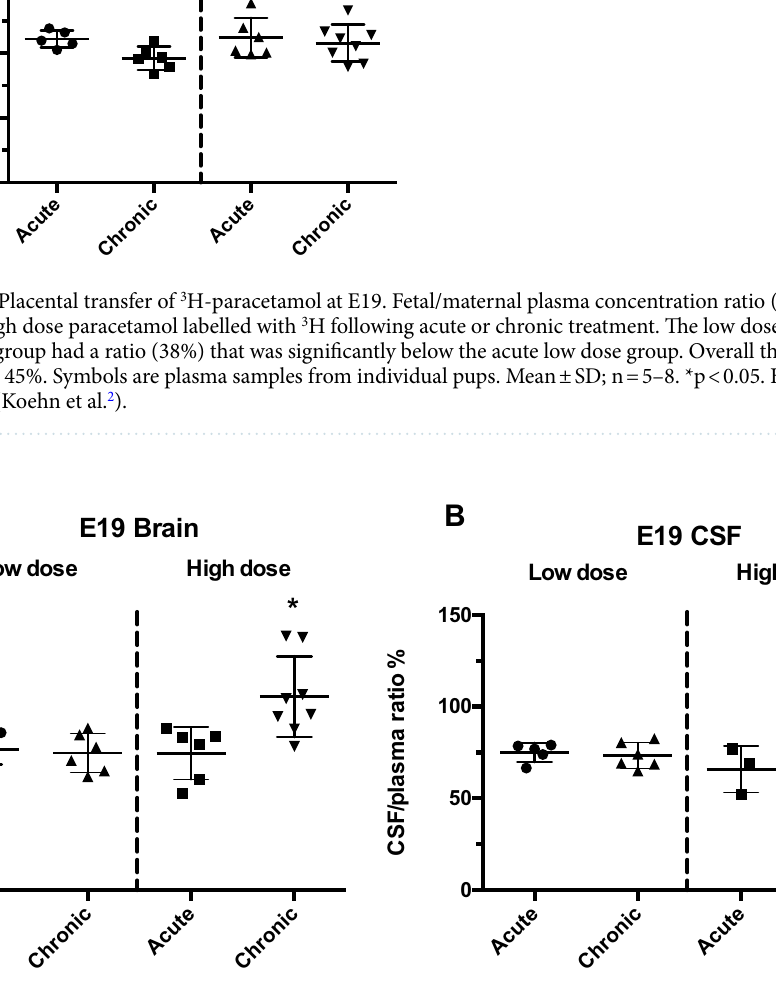
and adult (Fig. 6D) rats exposed in vivo to 3 H-paracetamol (15 mg/kg) acutely. Figure 6A,B shows the minimal background level in control brains that were either: (i) not exposed to any radiolabelled drug (Fig. 6A) and (ii) a brain that was exposed to radiolabelled digoxin (Fig. 6B), which only enters the adult brain to a limited extent 2 . When compared to radioactive standards on the same film, the level of 3 H-radioactivity in both Fig. 6A and Fig. 6B were below the lowest detection of 3.1 nCi/mg. Sections from brains exposed to paracetamol show its uniform distribution in the P4 brain, with granular deposits throughout (Fig. 6C). Quantification from 3 H standards on the film indicates that radioactivity in the P4 brain was approximately 18.4 nCi/mg. Figure 6D shows paracetamol in a similar uniform distribution across the adult brain, with darker deposits in the corpus callosum and the striatum. Quantification in relation to 3 H standards on the film indicates that radioactivity in the adult brain was approximately 5.1 nCi/mg. This confirms the earlier observation that much less paracetamol enters the adult brain than the developing brain 2 see “Discussion” section. Effect of paracetamol exposure on expression of ABC transporters and related enzyme at E19 in placenta, fetal brain and adult brain. E19 placenta following paracetamol treatment of their mothers (acute and chronic). Compared to untreated (control) placentas, both acute and chronic treatment decreased placental expression of several ABC transporters: abcc2 (16-fold acute, 38-fold chronic), abcc8 (11-fold acute,